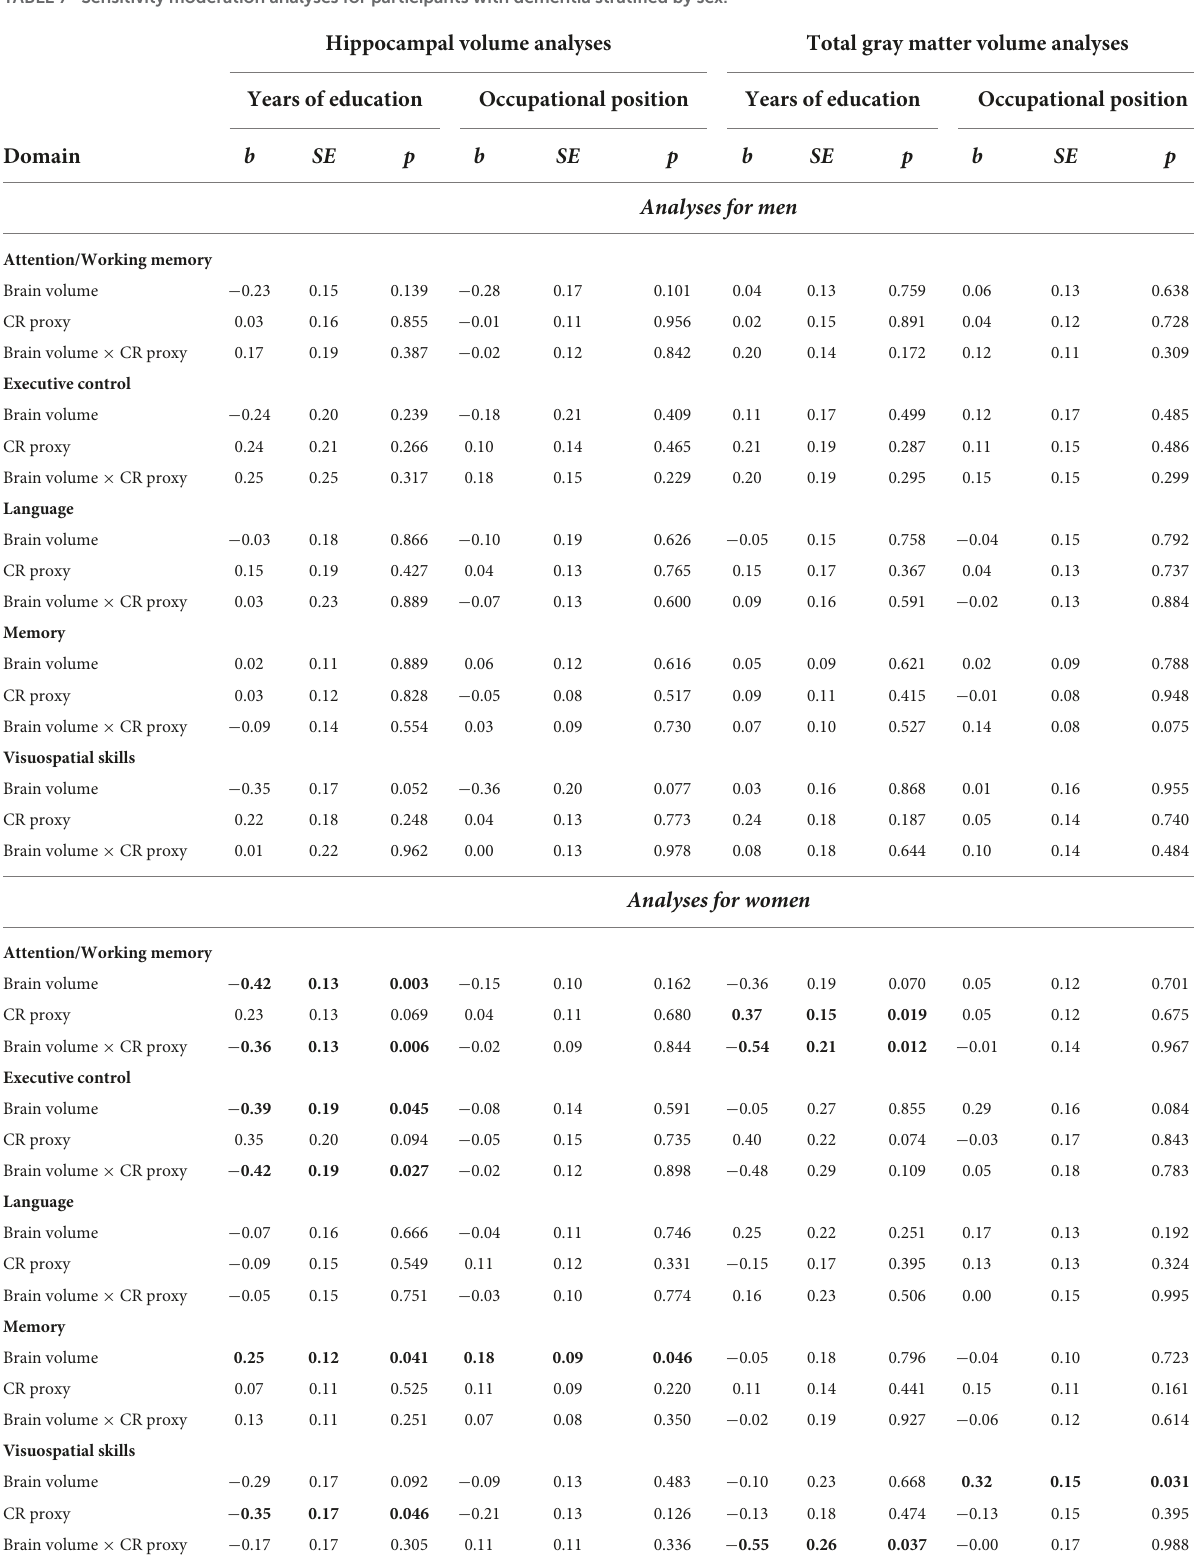
TABLE 7 Sensitivity moderation analyses for participants with dementia stratified by